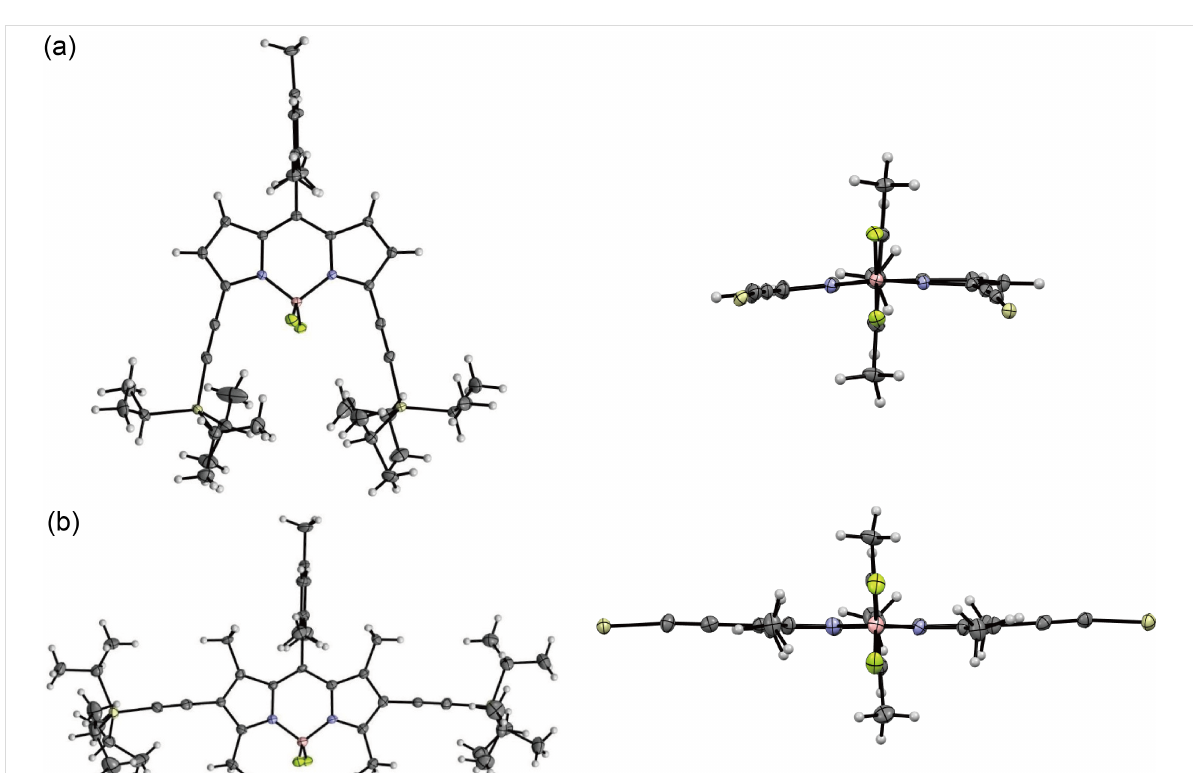
Figure 2: Top and front views of the crystal structures of (a) 4a and (b) 6b with 50% thermal ellipsoid probabilities. The isopropyl groups on the silicon atom are omitted in the front view for